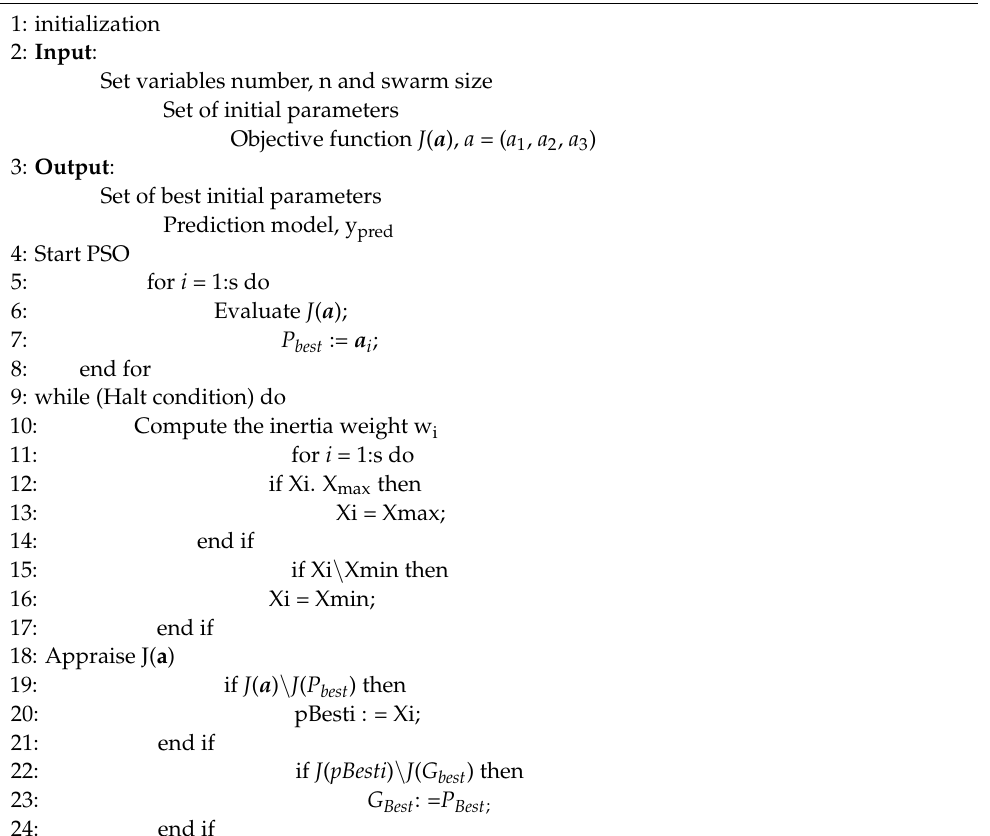
Algorithm 1: PSO implementation